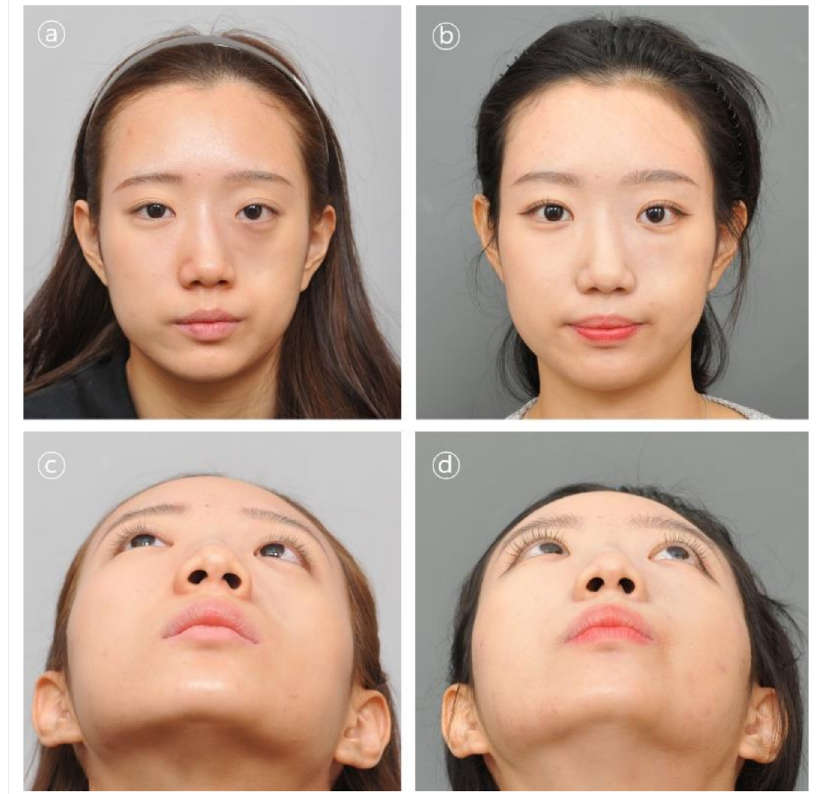
Figure 5. Clinical photographs in patient #1. Contour and symmetry of left cheek region was restored. ( a , b ) Pre- and postoperative 6-month frontal view photographs. ( c , d ) Pre- and postoperative 6-month basal view